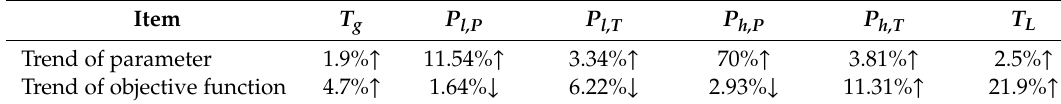
Table 5. Influence of each parameter change on the objective function.